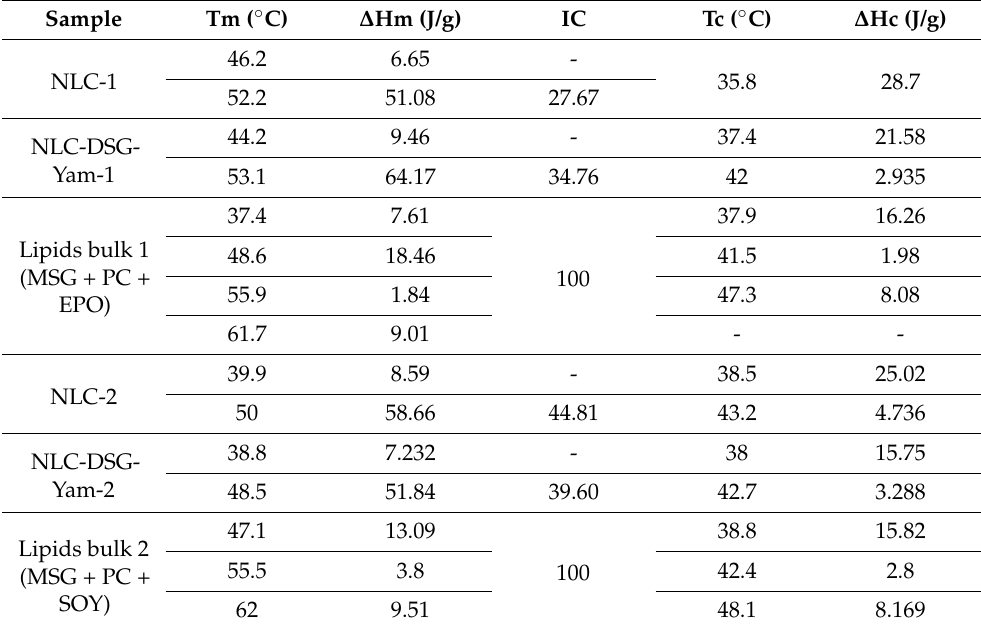
Table 2. Characteristics of bulk lipids, free and DSG and/or Yam co-loaded lipid nanocarriers.